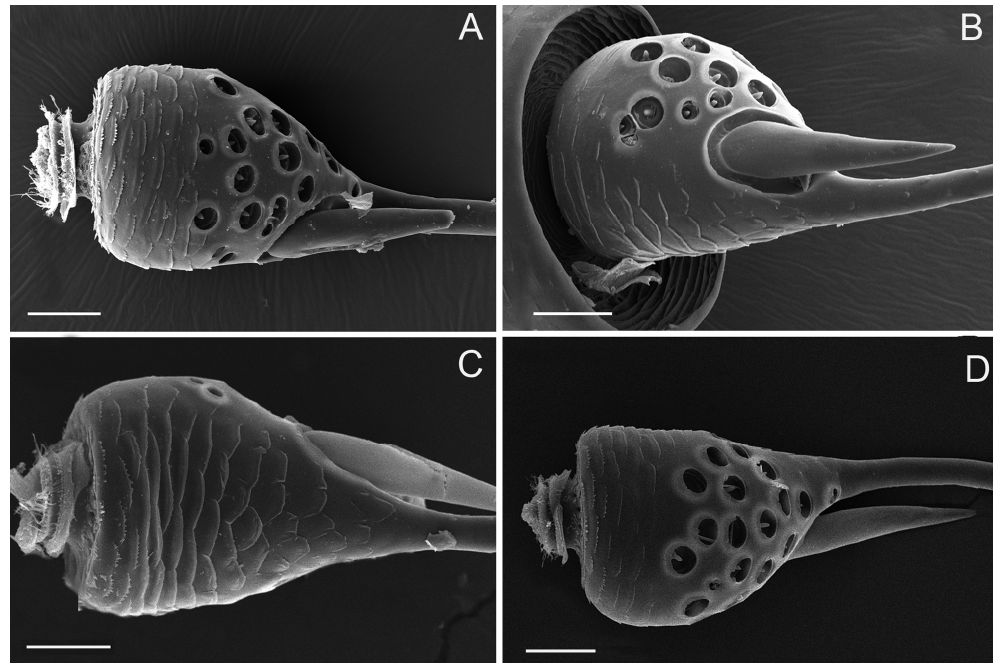
Figure 5. SEM micrographs showing the bulb-shaped portion of the flagellum in an adult female Callitettix versicolor’s (Fabricius) antenna. ( A ) Posterior side; ( B ) Ventral side; ( C ) Anterior side; ( D ) Dorsal side. Scale bars: A, B, C, D = 25 μm.